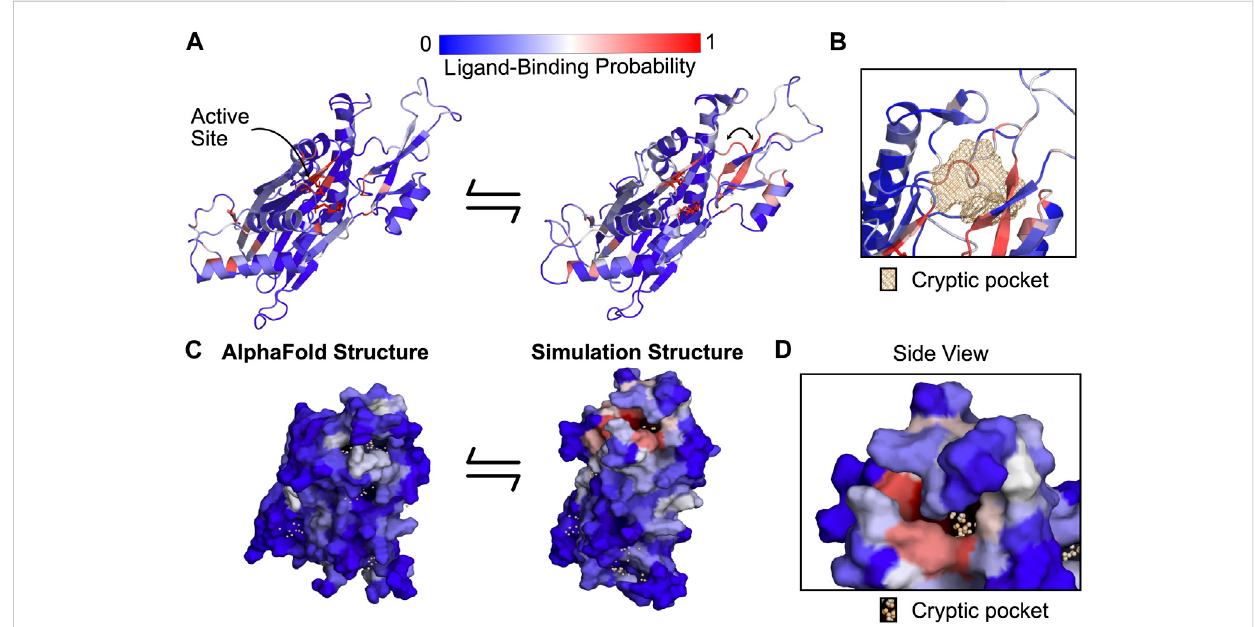
FIGURE 3 PPM1D apo simulations reveal a cryptic pocket at the fl ap-hinge interface. (A) The AlphaFold-predicted PPM1D structure and a simulation structure whereeachresidueiscoloredbyitsP2Rank-predictedligand-bindingprobabilitiesshowanincreaseinligand-bindingprobabilityatthe fl apdomainnear thehinge. This simulation structure wasselectedbecause it had thelargest increases in ligand-binding probability relative to thestarting structureacross the ensemble of states. Active site residues are shown in sticks. Arrow indicates the backbone motion that is required to form thecryptic pocket. (B) Mesh representation of the cryptic pocket shows that it forms between a fl ap domain loop (residues 276 – 279), two of the β -strands in the fl ap (residues 243 – 247 and 268 – 271), and a fl ap domain helix (residues 227 – 234). (C) Surface representation looking onto the AlphaFold structure and the open simulation structure highlights that a deep trench forms between the fl ap domain and hinge. The surface is colored by P2Rank-predicted ligand-binding probability. (D) Azoom-inofthesurfacerepresentationoftheopenstaterevealsthatthecrypticpocketliesinadeepgroove.Theorangespheresarethe pocket grid points identi fi ed by P2Rank.